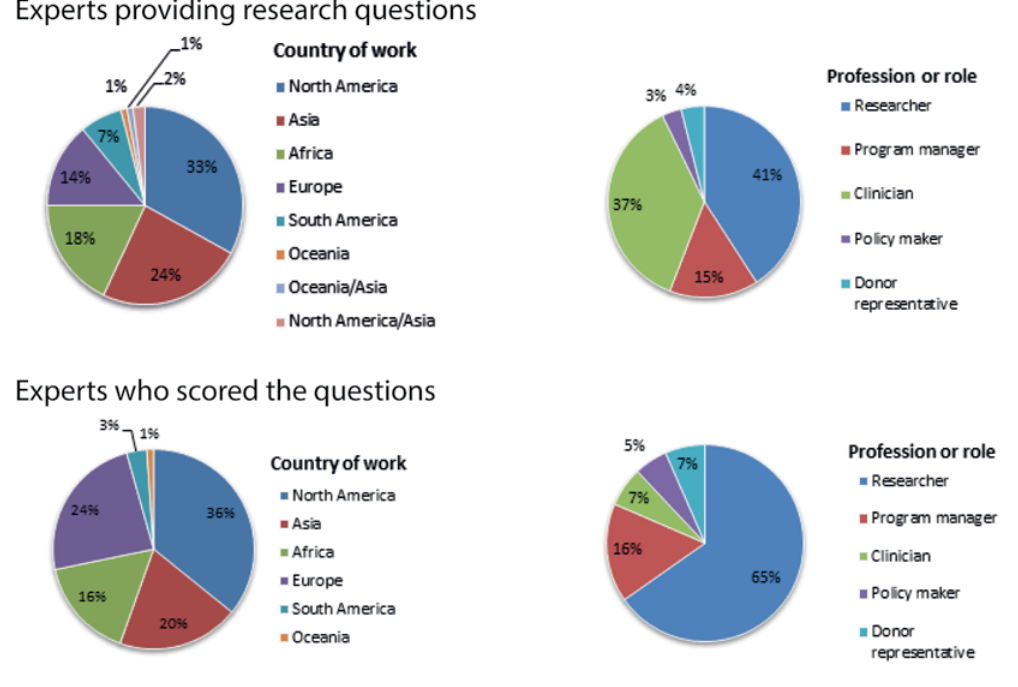
Figure 1. Background characteristics of 132 experts who provided questions and 91 experts who scored the